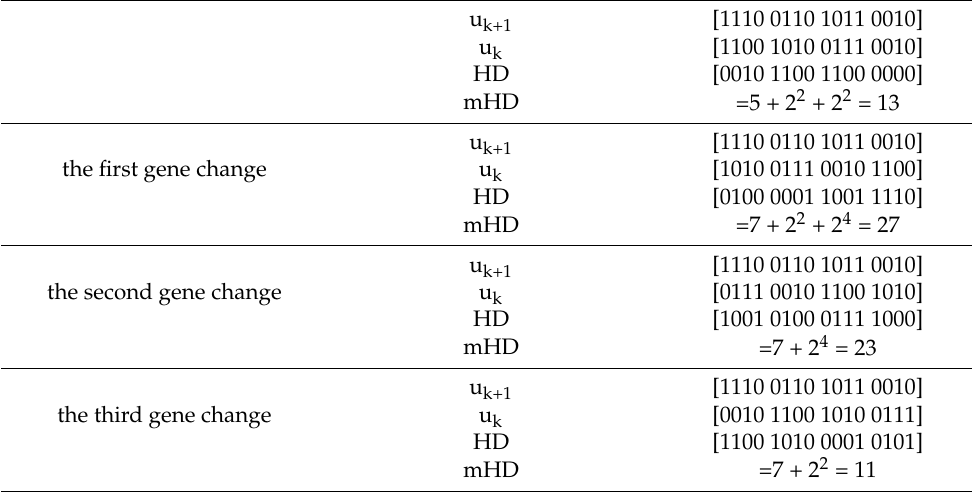
Table 3. The example of computing the degree of affinity between u k+1 and u k